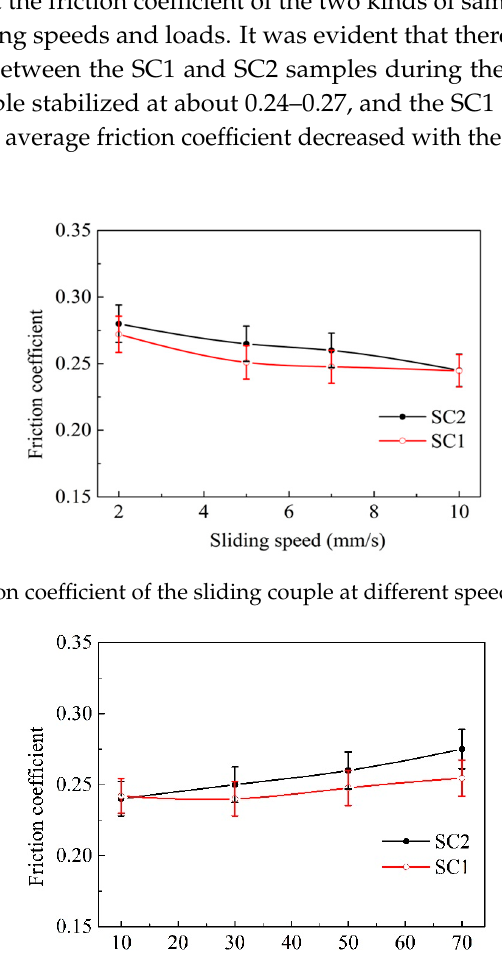
Figure 3. Experimental setup in dry cutting of hardened steel.